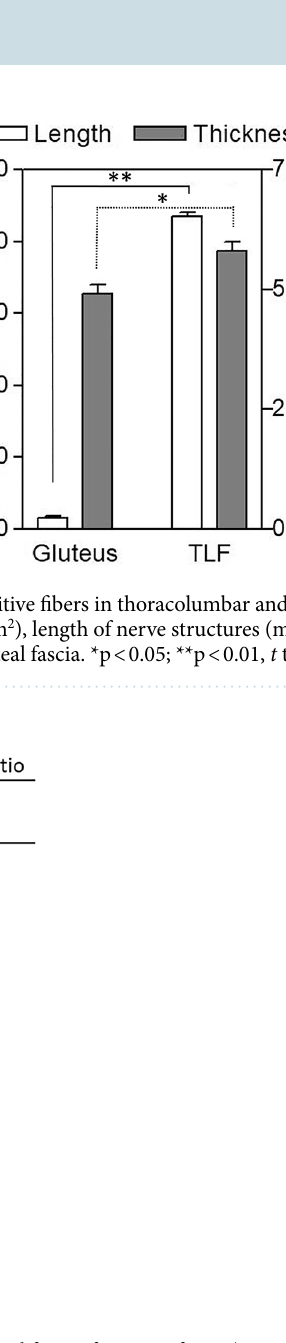
Figure 6. Autonomic innervation in thoracolumbar and gluteal fascia: fraction of area (IR area %) positive to Tyrosine Hydroxylase (TH) and values of S100/TH ratio, in thoracolumbar fascia (TLF) and gluteal fascia, expressed as mean ± standard error